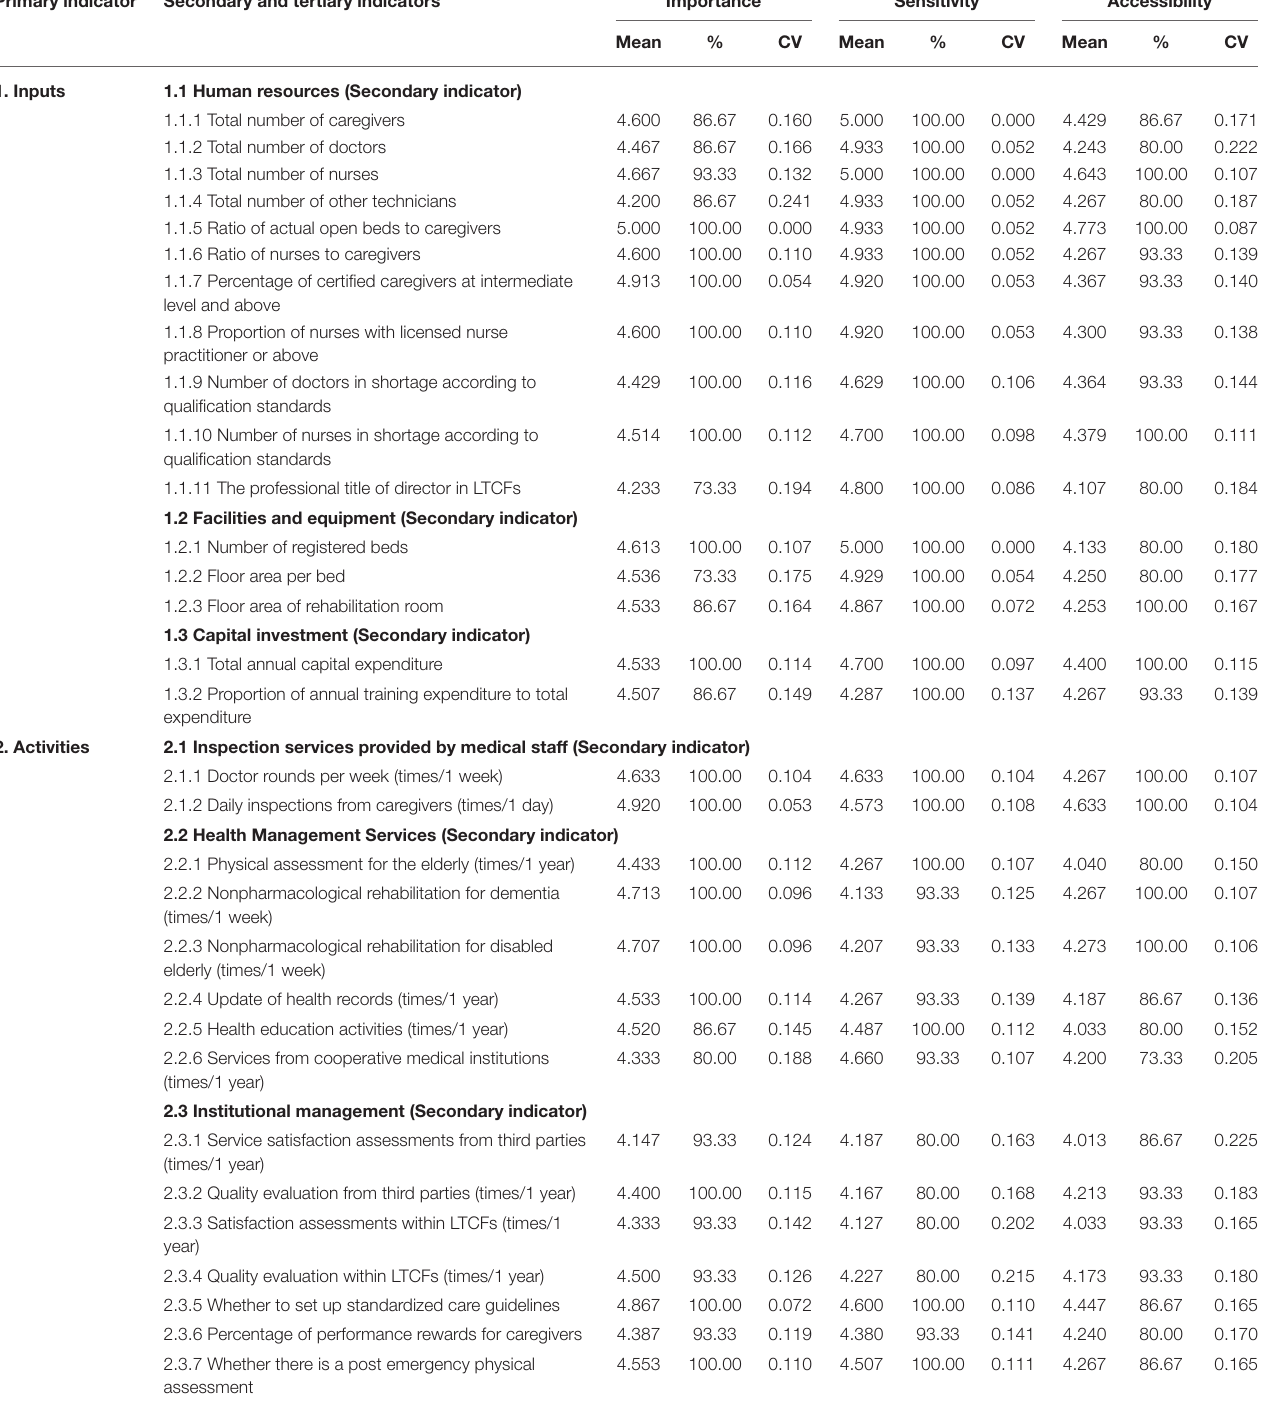
TABLE 5 | LTCF’s service capability evaluation index system. Primary